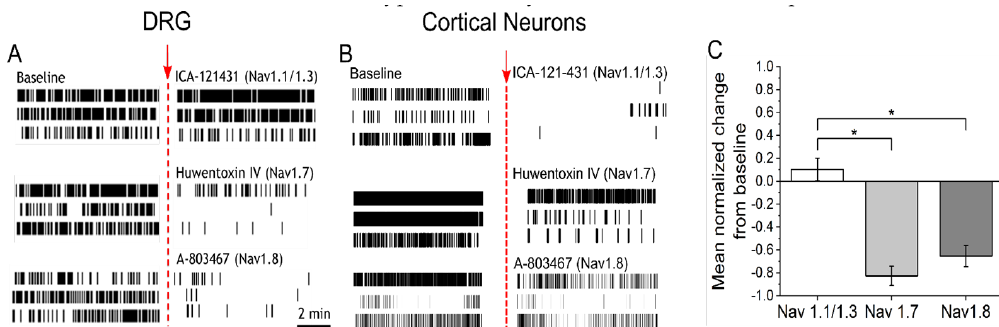
Figure 2. Potent and selective antagonists of Nav1.7 and Nav1.8 inhibit spontaneous activity in sensitized DRG cultures ( A ) Representative raster plots of three active electrodes in baseline (left) and after addition (right) of either 23 nM ICA-121431 (top), 30 nM huwentoxin-IV (HWTX-IV) (middle), or 300 nM A-803467 (bottom). Inhibitors of sodium channel subtypes were administered on cultures sensitized with IL6 + NGF for a period of 72 hours. ( B ) Representative raster plots of three active electrodes in baseline and equivalent treatments in DIV21 embryonic cortical cultures. ( C ) Mean normalized change in firing rate from baseline of DRG cultures after addition of ICA-121431 (Nav1.1/1.3), HWTX-IV (Nav1.7), or A-803467 (Nav1.8). Error bars are represented as mean ± standard error of the mean (SEM). * p < 0.05, ** p < 0.01, and *** p < 0.001.